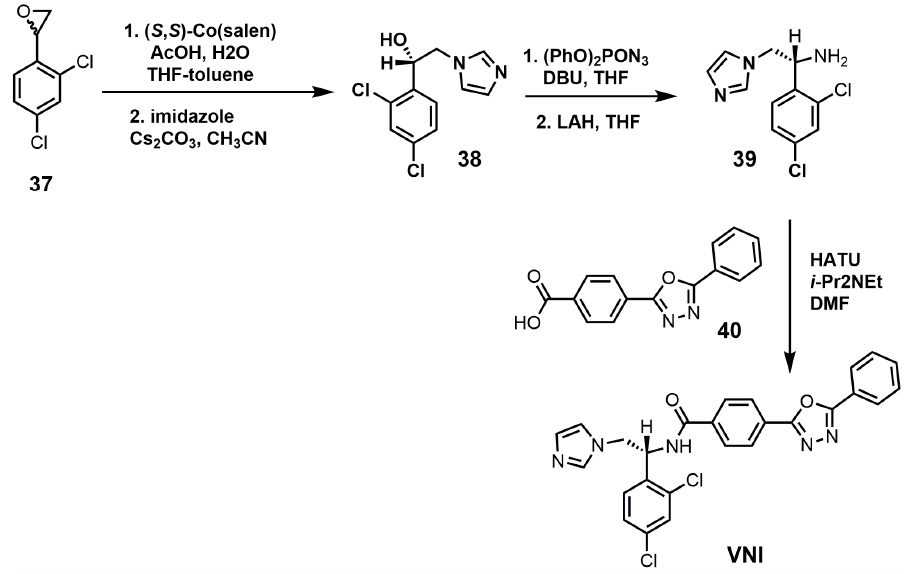
Figure 17. Synthesis of ( R )- N -(1-(2,4-dichlorophenyl)-2-(1 H -imidazol-1-yl)ethyl)-4-(5-phenyl-1,3,4-oxadi-azol-2-yl)-benzamide (VNI).